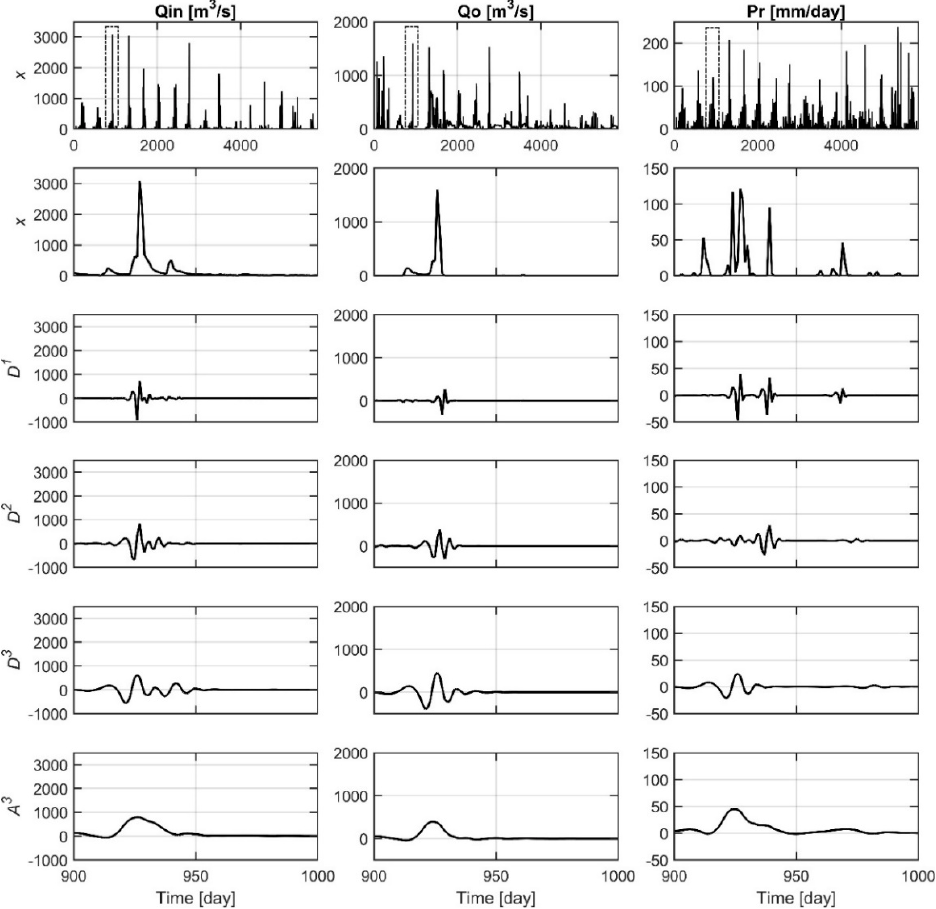
Figure 6. Decomposed time series for the three principal input variables (Qin, Qo, and Pr) after wavelet transform. x denotes the original time series; D 1 , D 2 , and D 3 denote the ‘Detail’ time series at the levels of 1, 2, and 3, respectively; A 3 refers to the ‘Approximation’ time series among the decompositions of x at the level 3. The subplots from the second row to the end row are zoomed in for the peak of the subplots of the first row (a period of 900-1000).